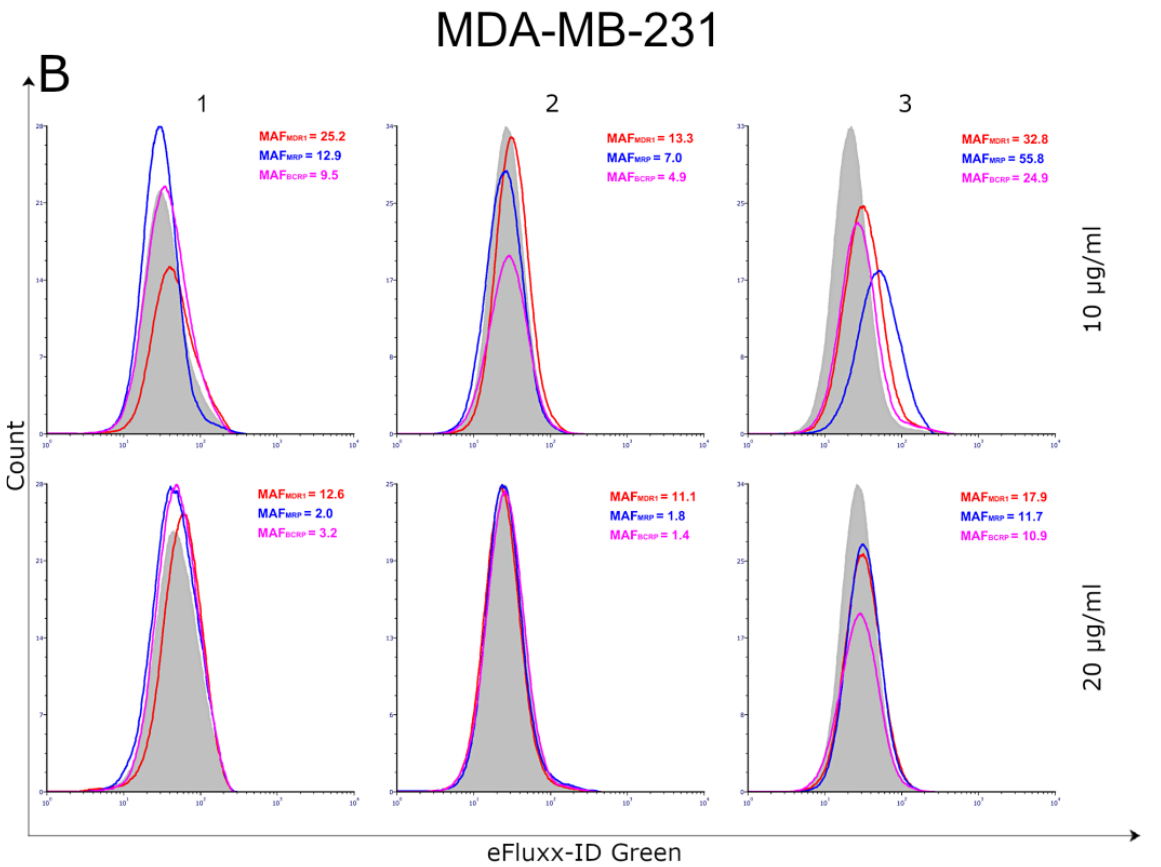
Figure 7. Flow cytometry analyses of ABC transporters in MCF-7 ( A ) and MDA-MB231 ( B ) cell pretreated with compounds 1 – 3 . The compounds were tested at the following concentrations: 1 (10 µg/mL/23.83 µM and 20 µg/mL/47.66 µM), 2 (10 µg/mL/22.75 µM and20 µg/mL/45.50 µM), 3 (10 µg/mL/23.78 µM and 20 µg/mL/47.56 µM) and etoposide (10 µg/mL/17 µM and 20 µg/mL/34 µM).Cells were incubated with Efflux Green Detection Reagent, with and without specific inhibi- tors (Verapamil, MK-571 and Novobiocin). Gray histograms show the fluorescence of the sample without an inhibitor, while tinted histograms show the fluorescence of cells treated with appro- priate inhibitors (MDR1 — red histogram, MRP — blue histogram and BCRP — pink histogram). The difference in fluorescence is indicative of theprotein activity. The numbers in the upper right cor- ners are MAF scores (multidrug resistance activity factors) that quantitatively characterize the